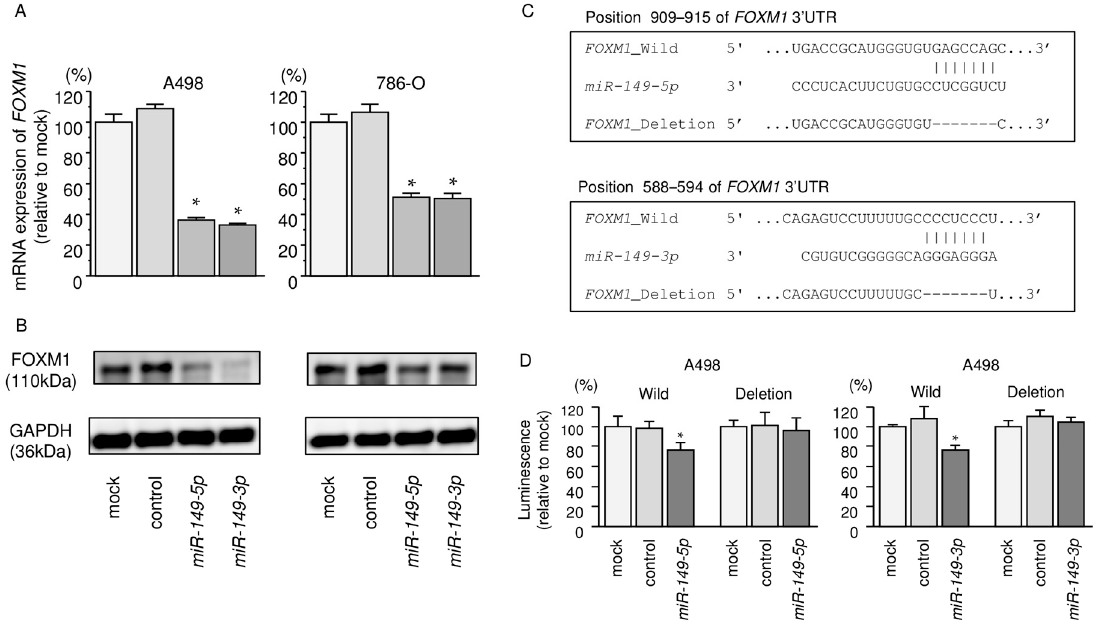
Figure 6. Direct regulation of FOXM1 by miR-149-5p and miR-149-3p in RCC cell lines. ( A ) FOXM1 mRNA expression in RCC cell lines was evaluated by qRT-PCR. GAPDH was used as an internal control. * p < 0.0001; ( B ) FOXM1 protein expression in RCC cell lines was evaluated by Western blot analyses. GAPDH was used as a loading control; ( C )The miR-149-5p or miR-149-3p binding site in the 3 (cid:48) -UTR of FOXM1 mRNA; ( D ) Dual Luciferase reporter assays using vectors encoding putative miR-149-5p and miR-149-3p target sites of the FOXM1 3 (cid:48) -UTR (positions 909–915 and 588–594) for both wild-type and deleted regions. Normalized data were calculated as ratios of Renilla / Firefly luciferase activities. * p < 0.001.